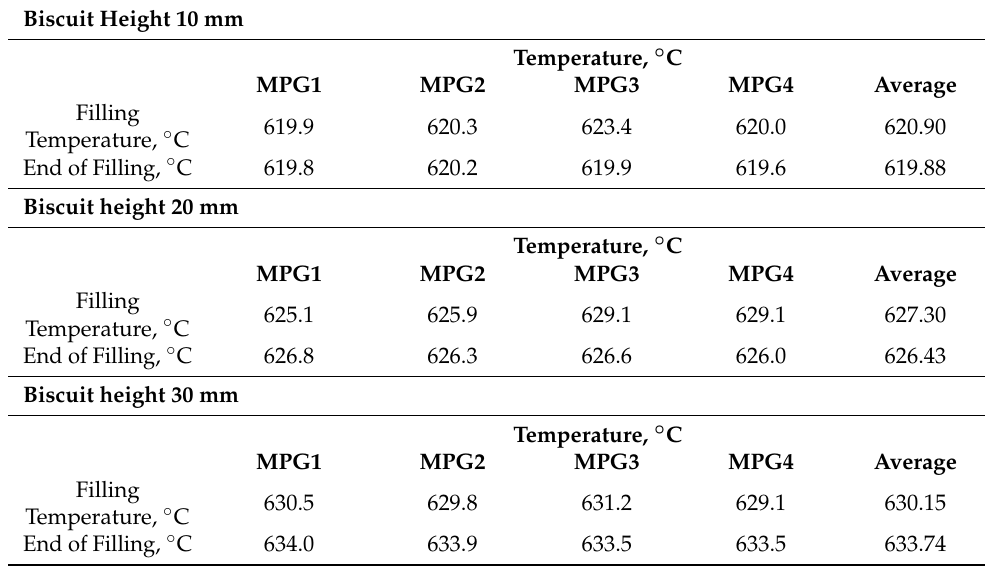
Table 4. Values of temperature of the melt in the gate area and its dependence on biscuit height Z.